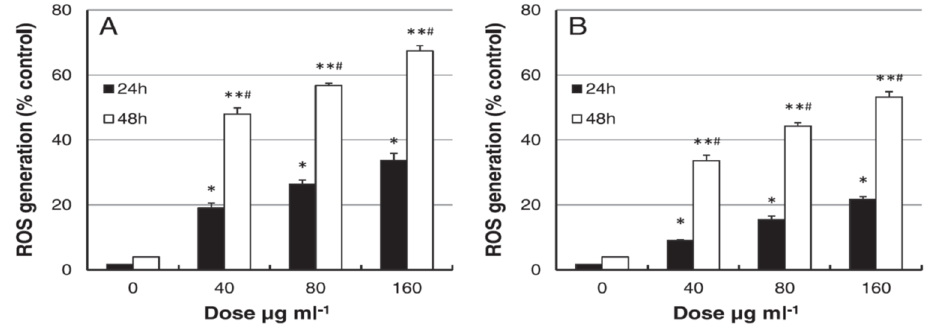
22 of 48 Figure 19. ( A ) Cell viability and ( B ) membrane damage of HBEC5i, HUVEC and EA.hy926 cells vs AgNPs concentrations after 24 h exposure to nanoparticles. Data are presented as means ± SD. * p < 0.05; ** p < 0.01; **** p < 0.0001. Reproduced from [59] with permission of Elsevier. The liver is one of the target organs once AgNPs enter the bloodstream [194,211,212]. Xue et al. demonstrated that AgNPs (15 nm) induce toxicity in HepG2 cells under a dose- and time-dependent